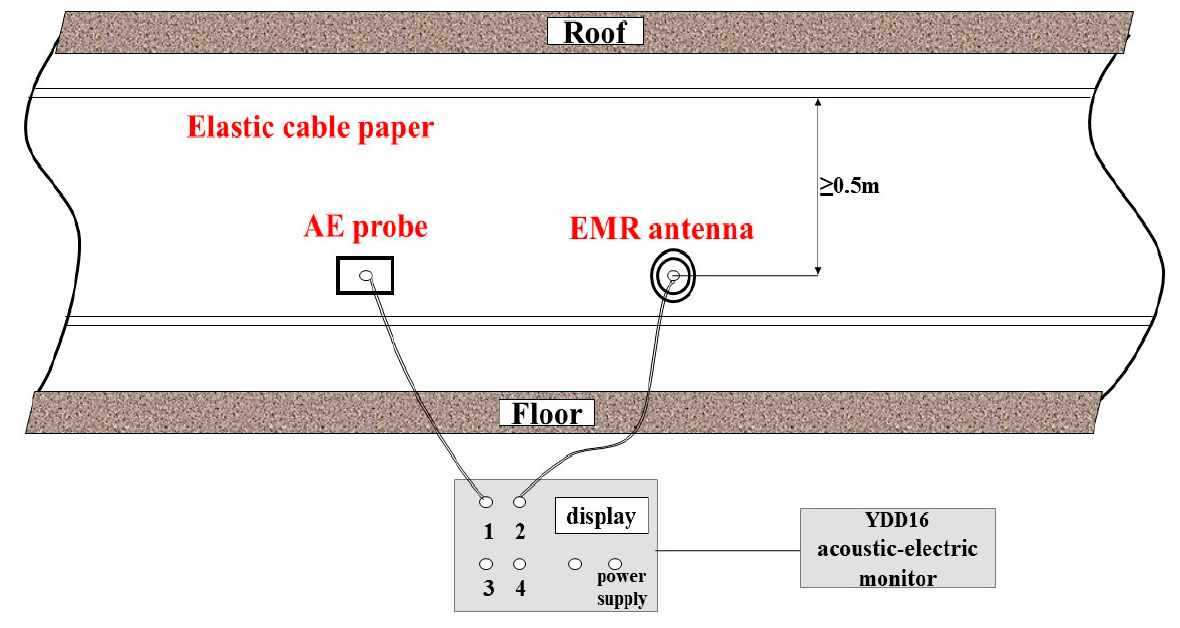
Figure 5. Use diagram of the YDD16 monitor.